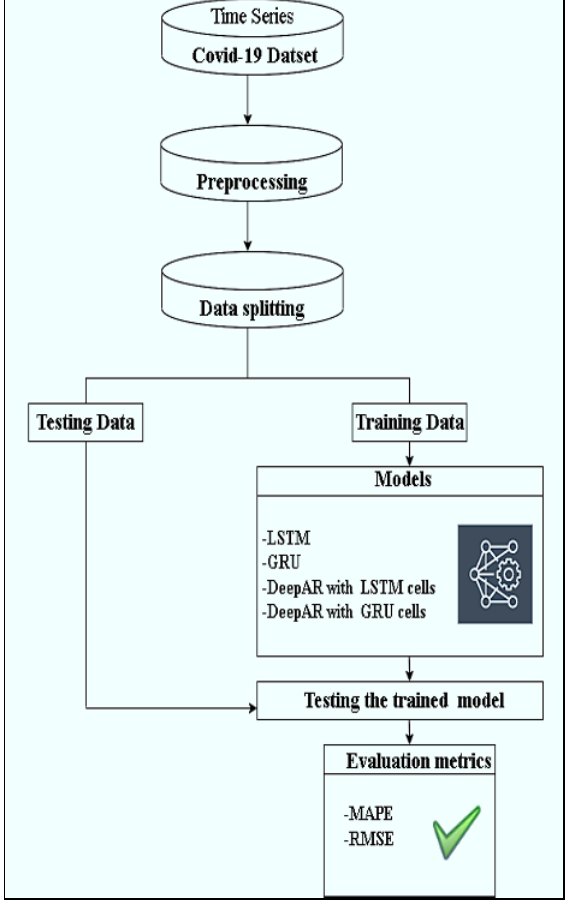
Fig. 2. Suggested Workflow